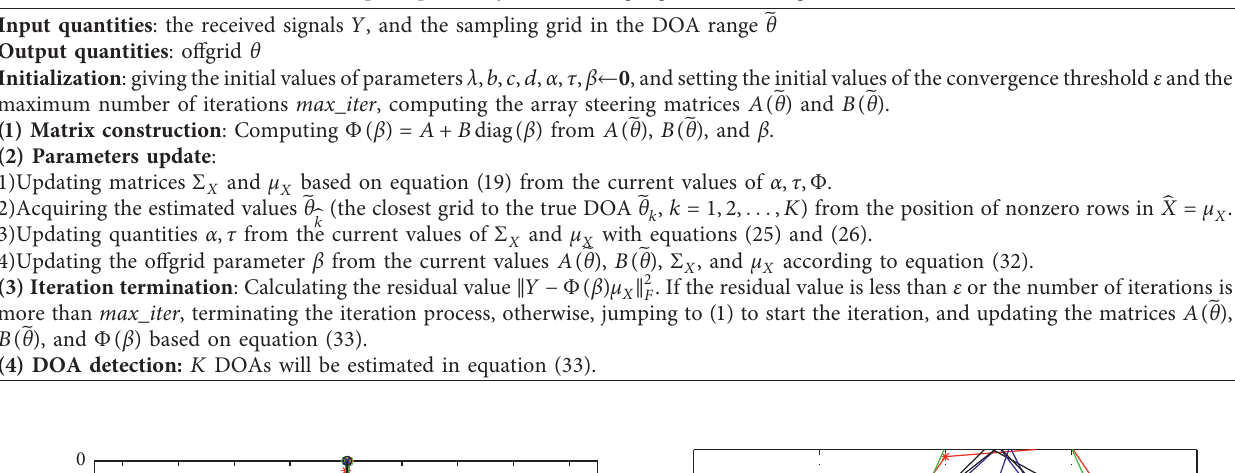
Table 1: Complex sparse Bayesian learning algorithm for offgrid DOA estimation.